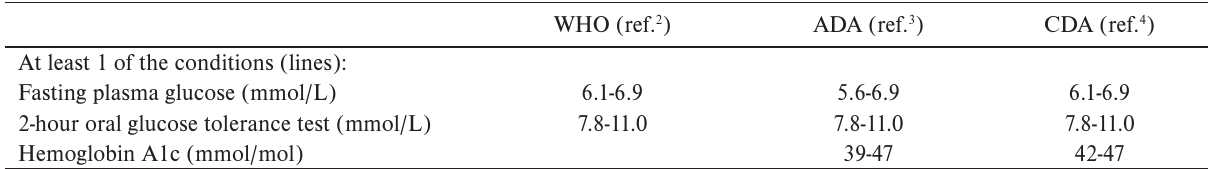
Table 1. Prediabetes criteria of various professional